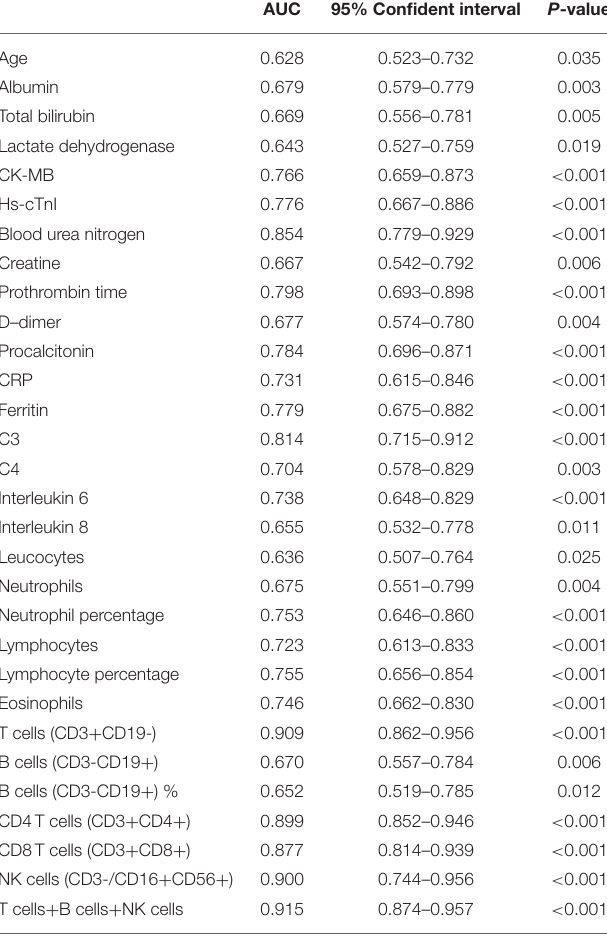
TABLE 3 | Prognostic value of the clinical